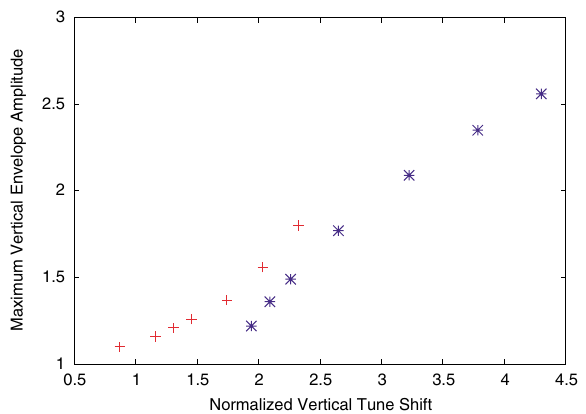
FIG. 4. (Color) The harmonic spectrum of the PSR vertical beta function. Plot (a) shows a large portion of the spectrum, while plot (b) zooms in on the low-order